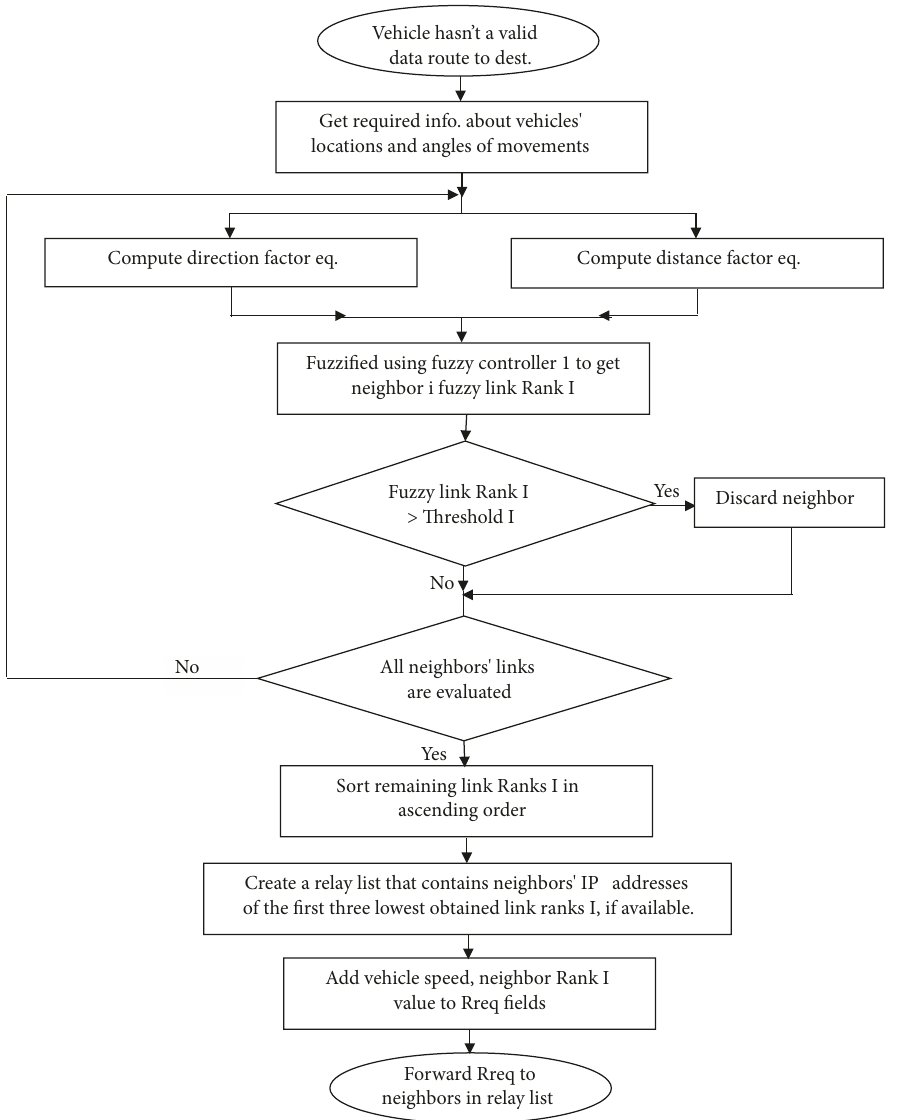
Figure 3: Additional steps of OFAODV before RREQ